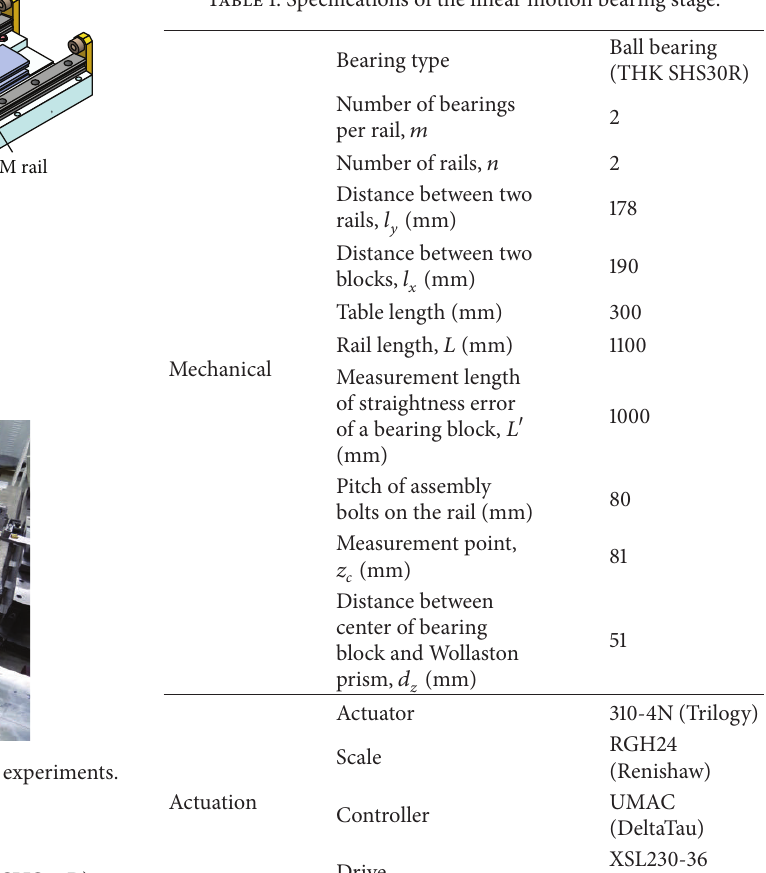
Table 1: Specifications of the linear motion bearing